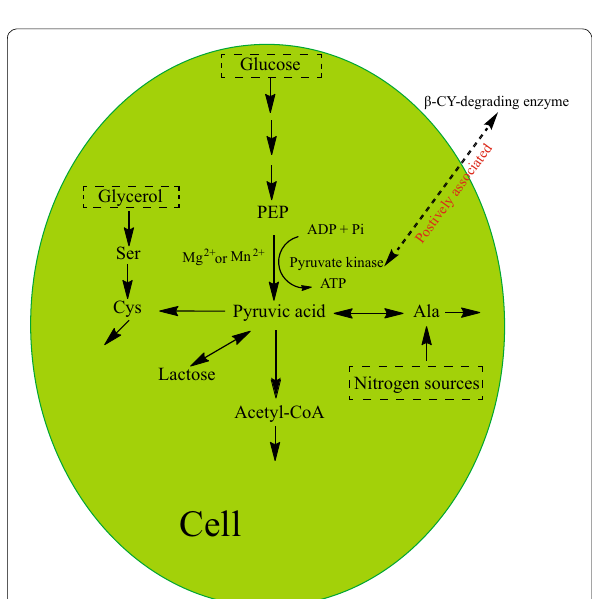
Fig. 4 Proposed pathway for nutrient regulation during co-metabolic degradation of β-CY by strain B-1. Co-metabolic degradation of β-CY by strain B-1 was positively associated with the activity of pyruvate kinase, which could be regulated by glucose, glycerol, and